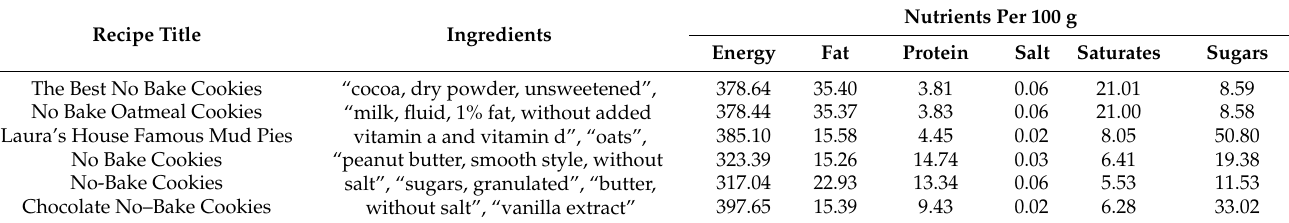
Figure 3. Visual representation of the vector representations without the domain-specific heuristic of a group of recipes with the same ingredients.